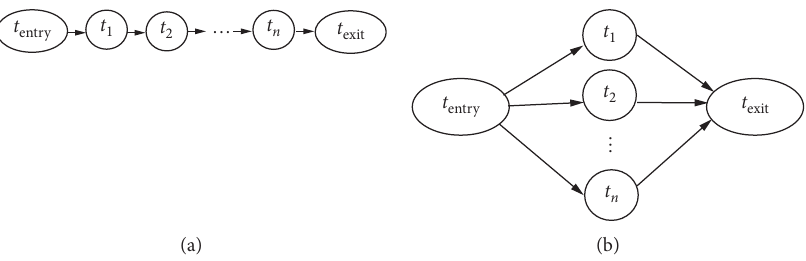
Figure 2: The structure of workflow. (a) Sequencial workflow process. (b) Paralleled workflow process.